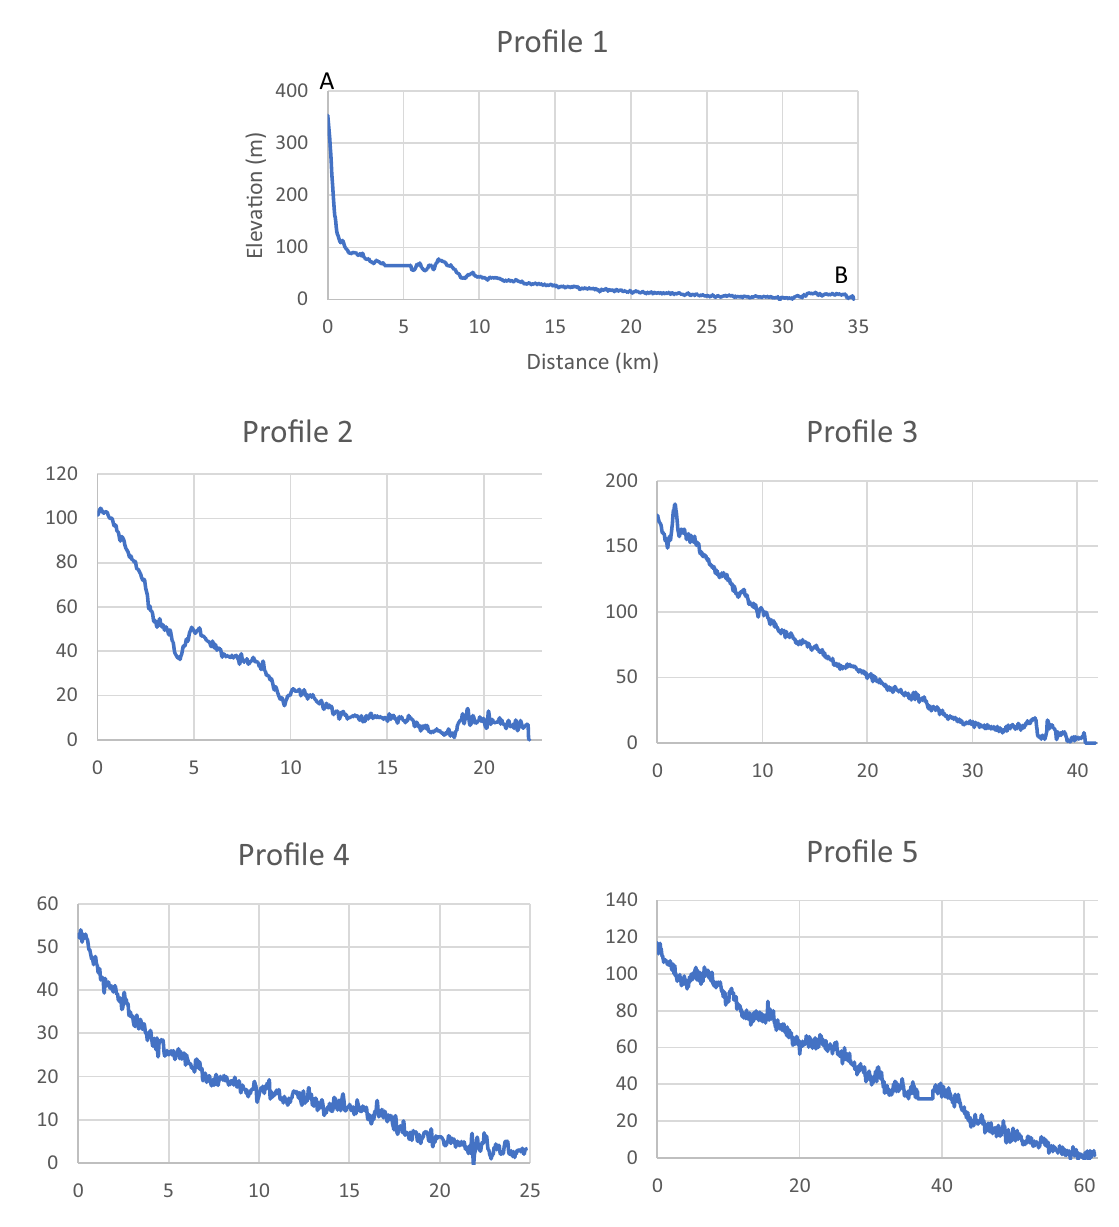
Fig. 19 Topographic profiles of different regions of southern Cuba. The profiles are represented in Fig.